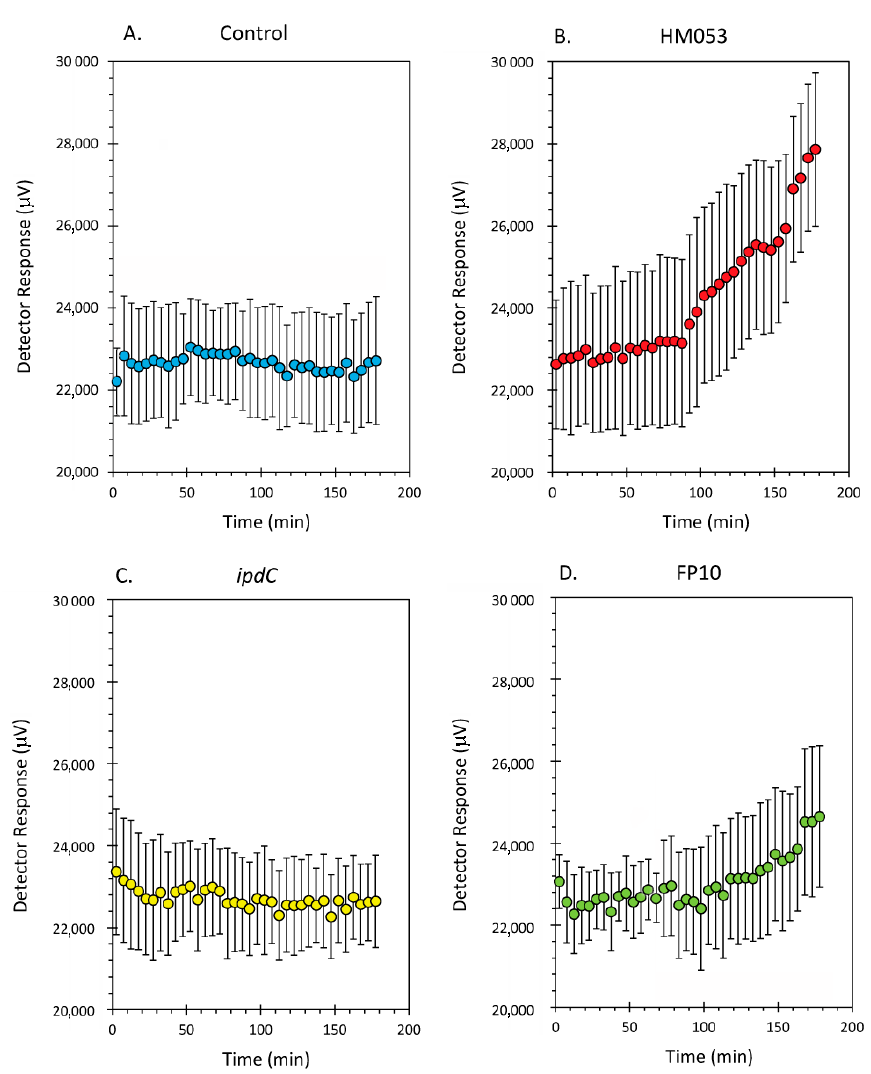
Figure 5C. Manganese levels within the endodermis were significantly elevated in HM053- inoculated plants as compared to controls.